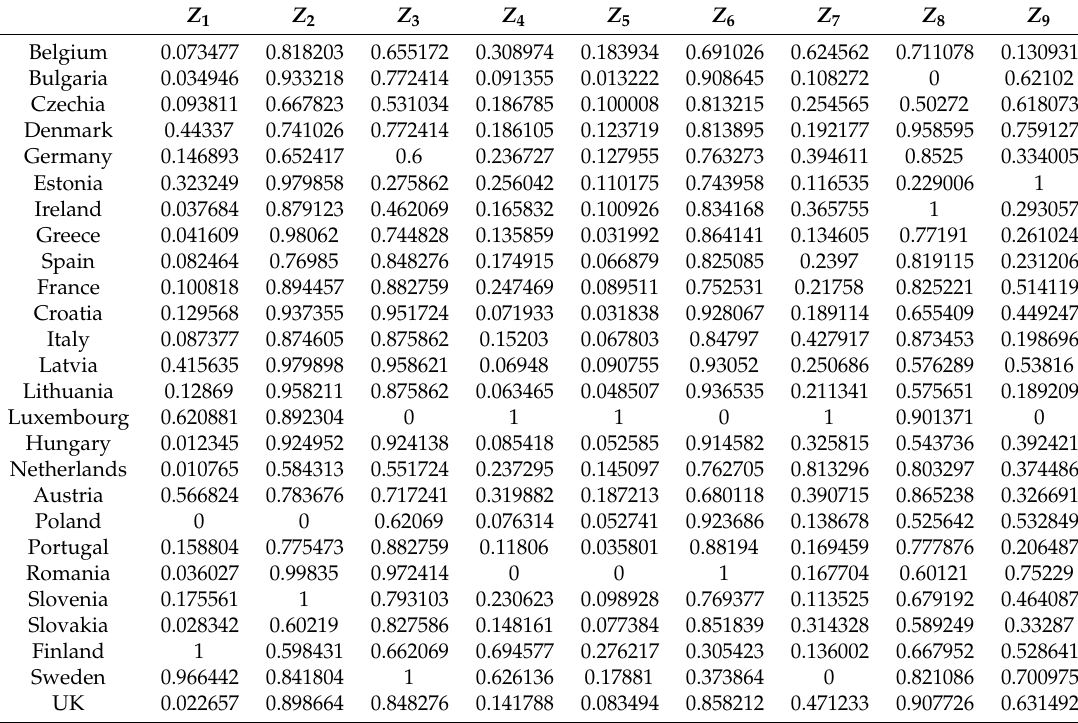
Table 5. The set of variables standardized for a 2018 year (own study).